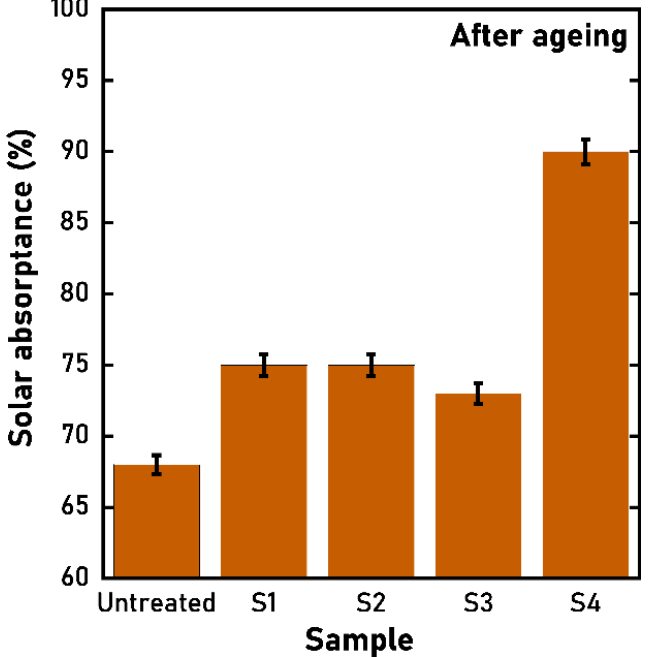
Figure 13. Solar absorptance of the four treated samples and the reference untreated one after the ageing process.